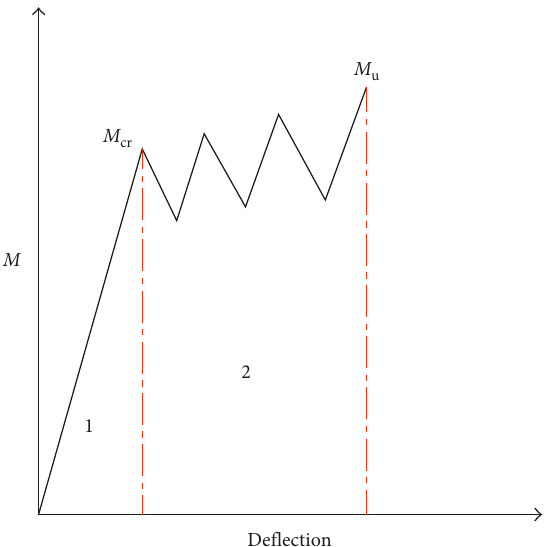
Figure 50: Failure process of the stone slab with NSM CFRP.